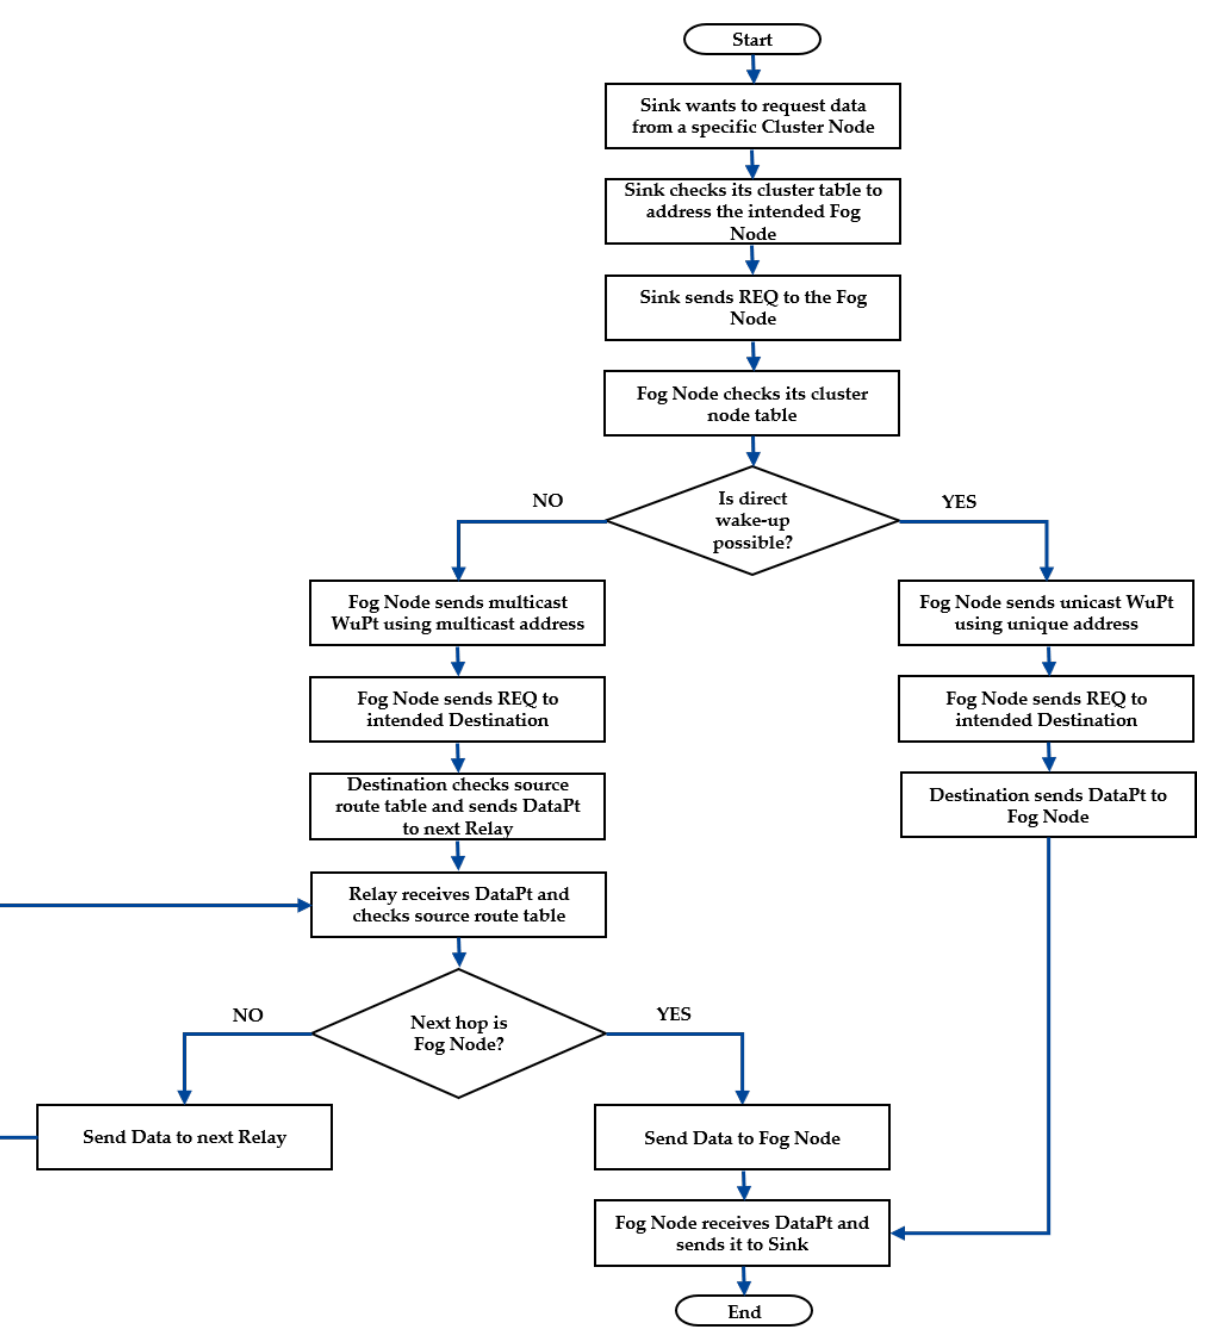
Figure 6. Communication using the proposed wake-up